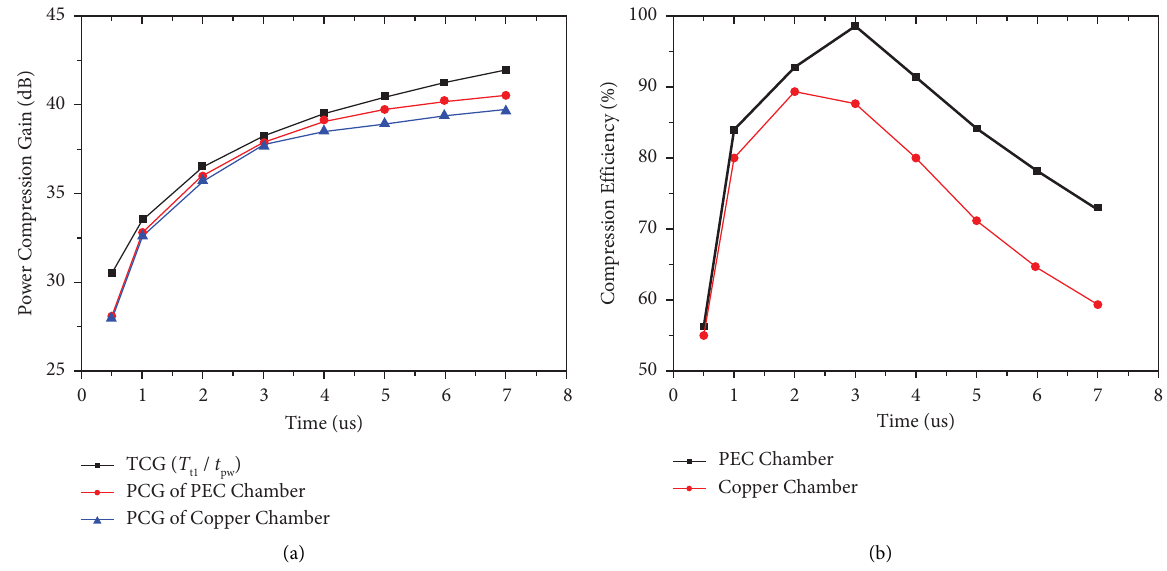
Figure 6: Te simulated pulse compression performance along with the time length of input pulse for the rectangular reverberation chamber with diferent materials. (a) Comparison of the simulated PCG along with the time length of input pulse for the rectangular reverberation chamber with PEC and copper materials. (b) Comparison of the simulated CE along with the time length of input pulse for the rectangular reverberation chamber with PEC and copper materials.